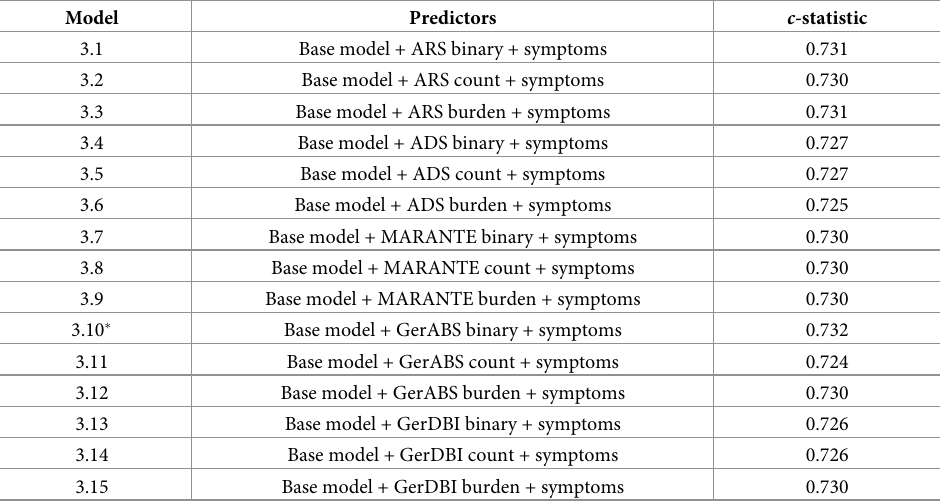
Table 2. Comparison of model performances from step 3A.